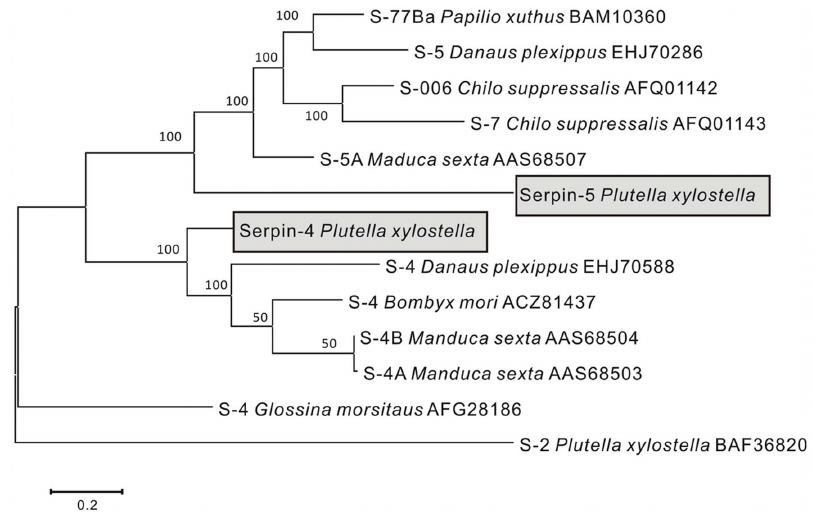
Figure 4. Consensus Neighbour-Joining tree based on the sequences of serpins. Maximum likelihood tree reconstruction based on sequences of serpins (length approximately 449) of representative sequences from Genbank under the WAG + G substitution model was carried out. The estimated value of the gamma shape parameter ( + G) was 1.70. The bootstrap values are indicated. Serpins number (abbreviated as S in tree), accession number and species name are shown along the sequence in the tree. Sequences used in this study are highlighted in the tree via grey colour.